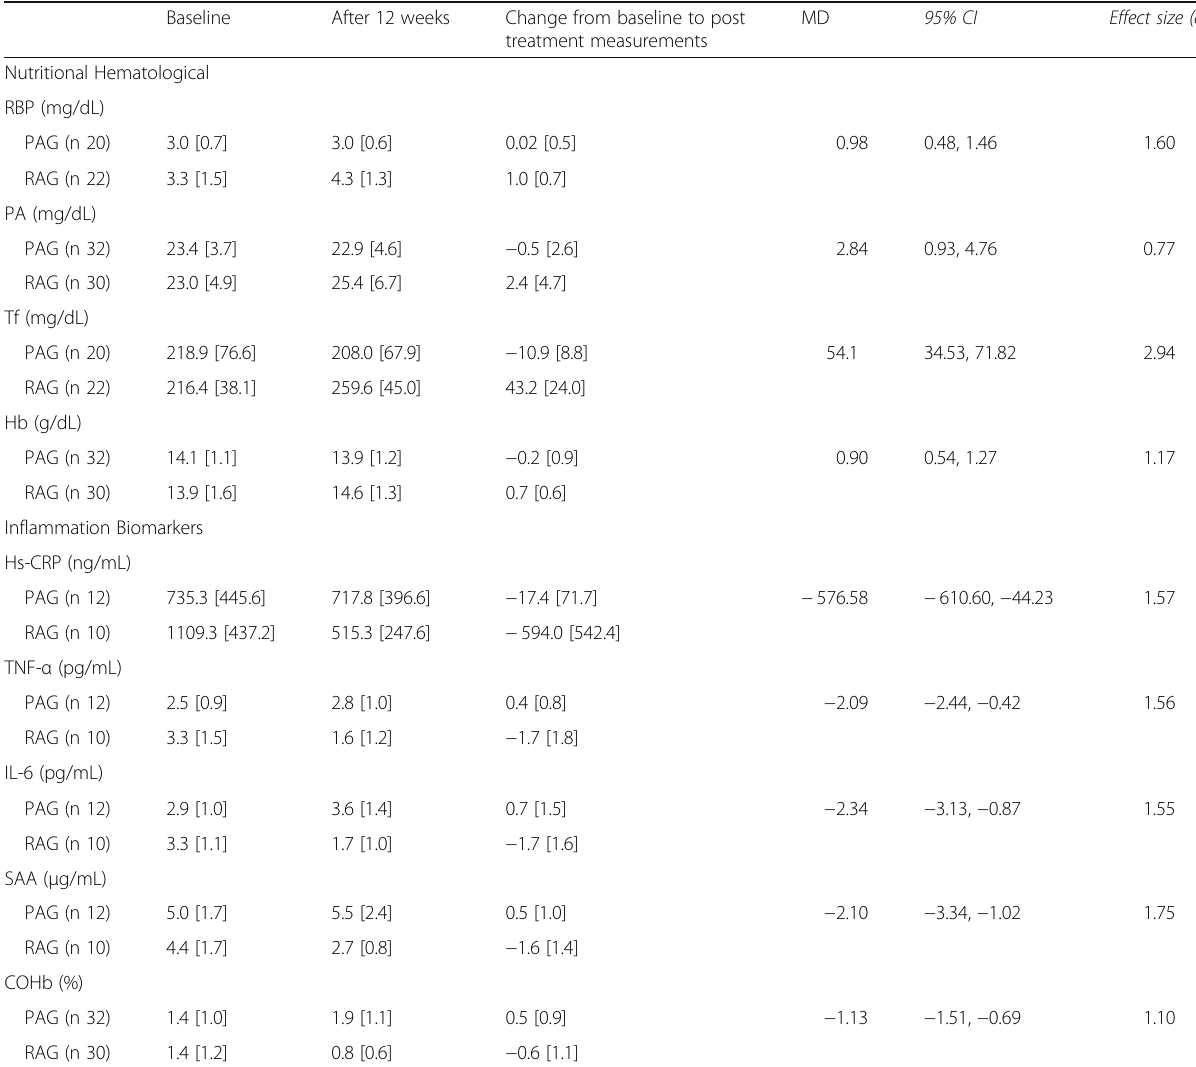
Table 4 Changes in the Nutritional Hematological and Inflammation Biomarkers Baseline After 12 weeks Change from baseline to post MD treatment measurements